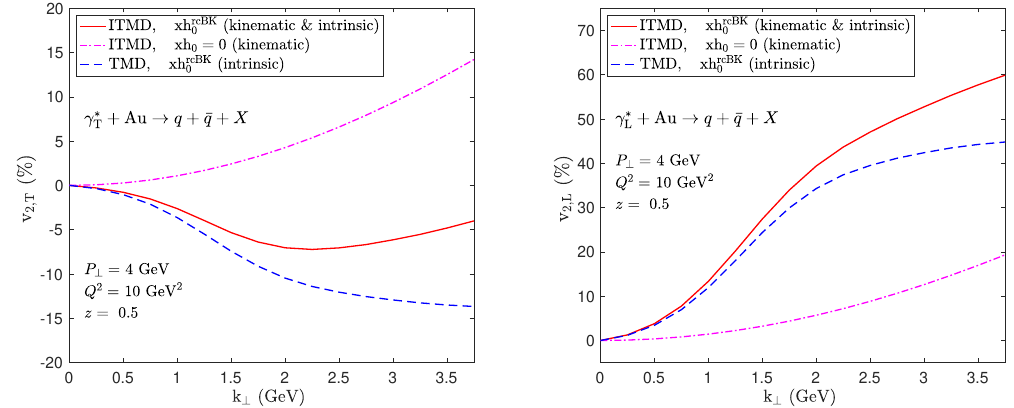
Figure 8 . Elliptic anisotropy in γ ∗ +Au → q + ¯ q + X for transversely polarized photons (left), and λ longitudinally polarized photons (right). We show results in the TMD (dashed) and ITMD (solid) framework. To illustrate the effect purely from kinematic twists, we also show the result for the ITMD in which we turn off the linearly polarized WW gluon TMD (dashed dotted).